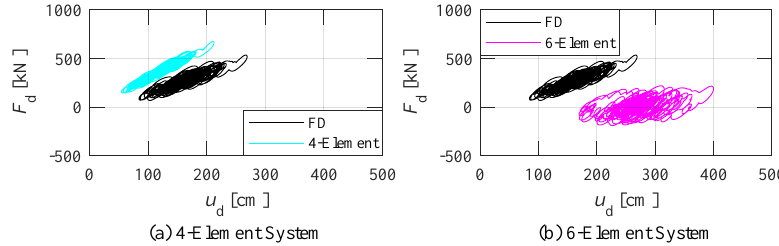
Figure 19. Comparison of hysteresis loop in the 2H-HH system (along-wind).